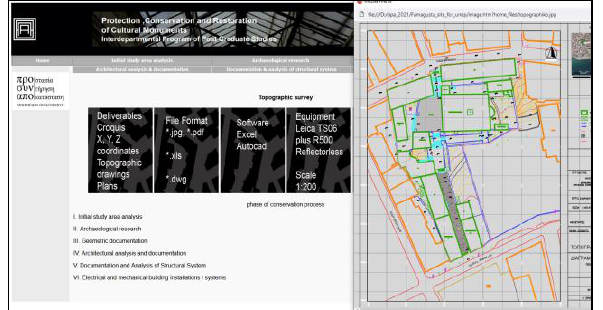
Figure 10 . Layout of the multimedia application (presentation of Geometric documentation / Topographic survey / Example: Topographic